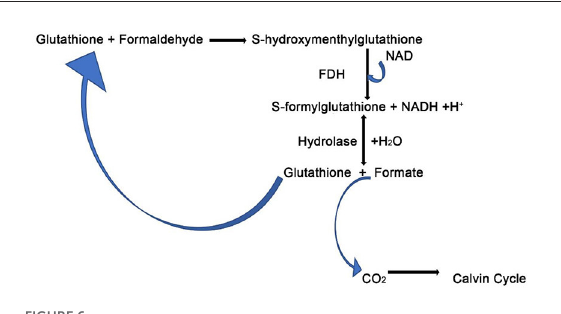
FIGURE6 Steps in the formaldehyde metabolism by formaldehyde dehydrogenase